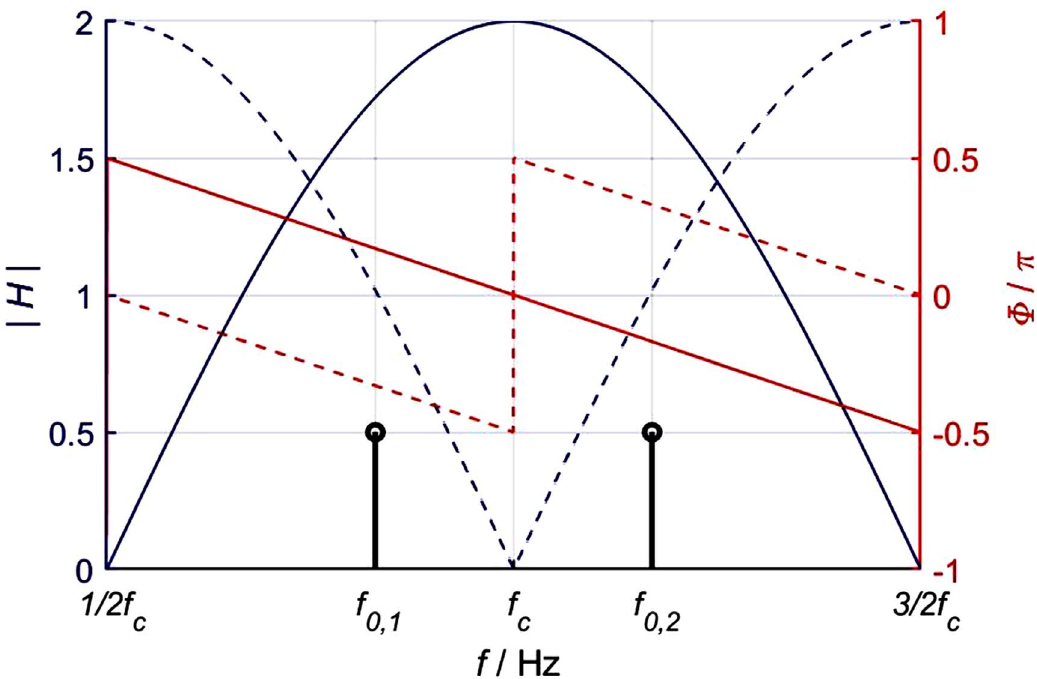
Figure 2. Filter transfer functions in the range between f c /2 and 3 f c /2, centered at the current PM-HLL oscillator frequency (i.e., fundamental frequency estimate) f c . The amplitude is shown in blue (left scale), and the normalized phase is shown in red curves (right scale). The period-constructive comb fi lter (solid lines) enhances a component at f c , whereas the period-suppressive comb fi lter (dashed lines) cancels it. If the true fundamental frequency f 0 of a signal is lower (indicated as f 0,1 ) or higher (indicated as f 0,2 ) than f c , the phase difference between the two comb fi lters is +90 (cid:3) or (cid:2) 90 (cid:3) , respectively. This phase difference is used by the PM-HLL algorithm as a control signal to adapt the fundamental frequency estimate f c towards f 0 . Note that, due to the periodicity of the transfer functions involved, the same behavior applies to all harmonics of the signal, i.e., the phase fl ip between +90 (cid:3) and (cid:2) 90 (cid:3) occurs at the same value of f c for the fundamental and all its harmonics. Thus, the fundamental and all its harmonics contribute to the control signal in the same